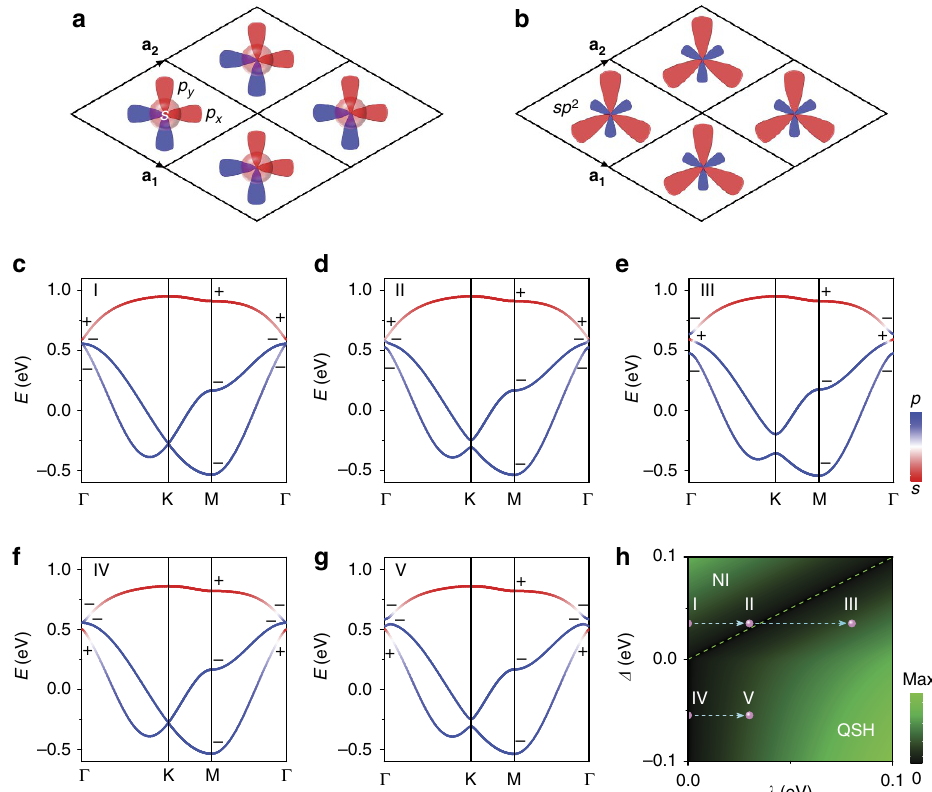
Figure 1 | Minimal basis tight-binding model for QSH phase in a trigonal lattice. ( a , b ) Trigonal lattice with three orbitals ( s , p x , p y ) per lattice site p p and its equivalent three sp 2 orbitals. a 1 ¼ ð ffiffiffi 3 = 2 ; (cid:2) 1 = 2 Þ and a 2 ¼ ð ffiffiffi 3 = 2 ; 1 = 2 Þ are lattice vectors. ( c – e ) The first-type band structures with parameter e s ¼ 0.83eV, e p ¼ 0eV, t ss s ¼ –0.04eV, t sp s ¼ 0.09eV, t pp s ¼ 0.18eV and t pp p ¼ 0.005eV. l is 0, 0.03 and 0.08eV for a , b and c , respectively. ( f , g ) The second-type band structures with e s ¼ 0.74eV and l ¼ 0, 0.03eV for f , g respectively. The other parameters are the same to those in c – e . From c – g , the red and blue colours indicate the component of s and p orbitals, respectively, and the parities for each sub-band at time reversal invariant momenta are labelled with þ and (cid:2) signs. ( h ) Topological phase diagram in the parameter space of D ¼ E s (cid:2) E p (bandgap between s and p orbitals at G point without SOC) and l (SOC strength). The colour indicates the bandgap between top and middle band. The band structure parameters for c – g are marked by the dots with labels I–V in h . The dashed line is the boundary between normal insulator (NI) and QSH phase. The dashed arrows indicate the increasing SOC strength.